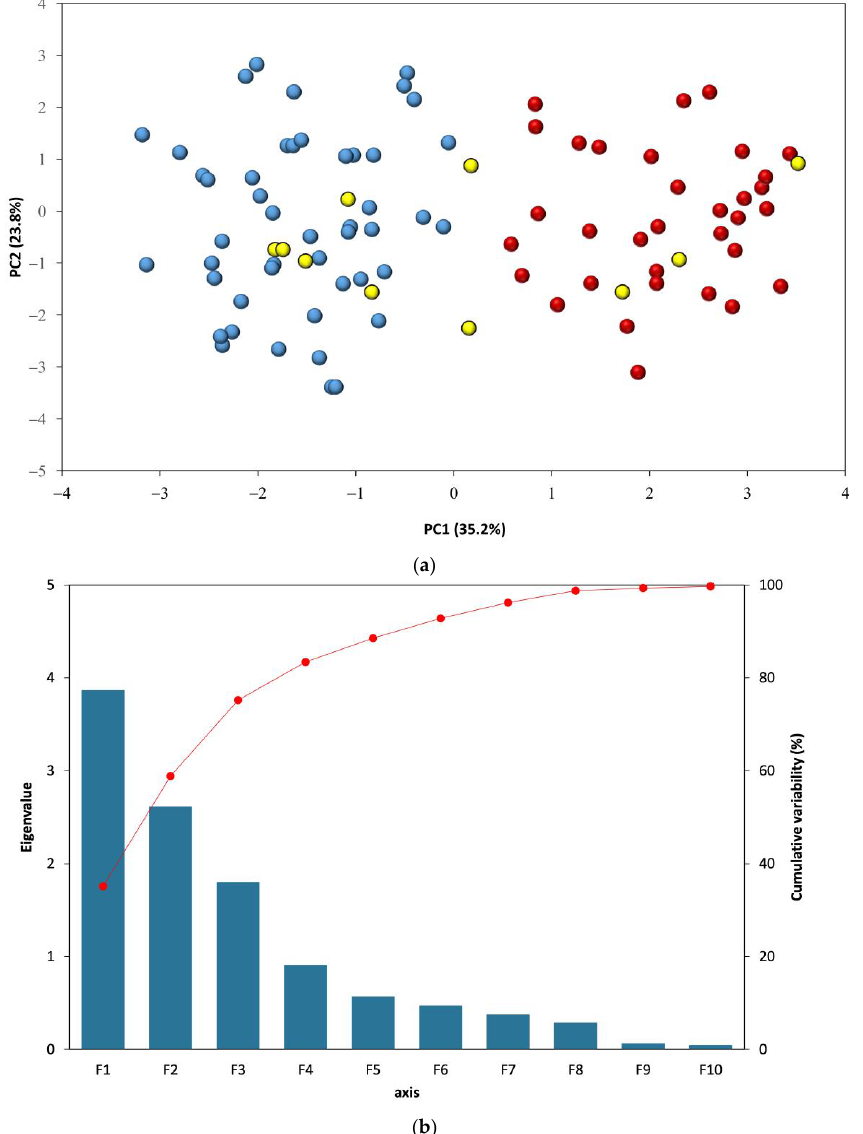
Figure 6. ( a ) PCA realized from the 10 molecular and organic element measurements (blue circles: leather, red circles: polymers, and yellow circles: synthetic leather). ( b ) Scree plot from the PCA shown in Figure 6a.